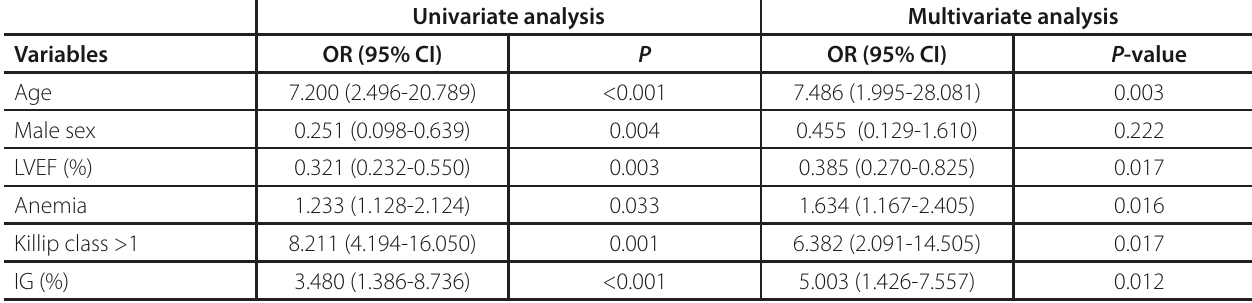
Table 3. Logistic regression analysis of the independent predictors of